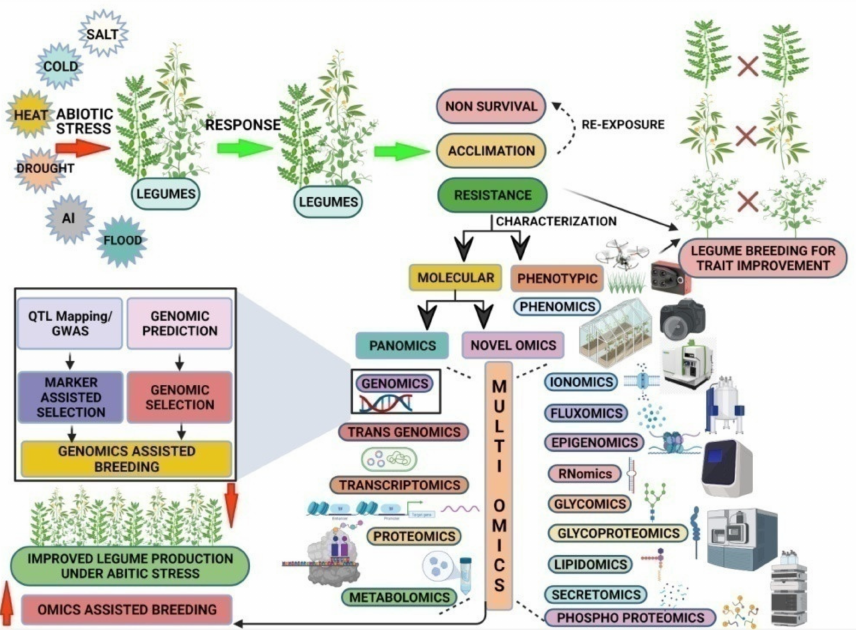
Figure 2. Integrated omics approaches for improving abiotic stress tolerance in legumes. QTL, Quantitative Trait Loci; GWAS, Genome-Wide Association Study. This figure was created by Bioren-